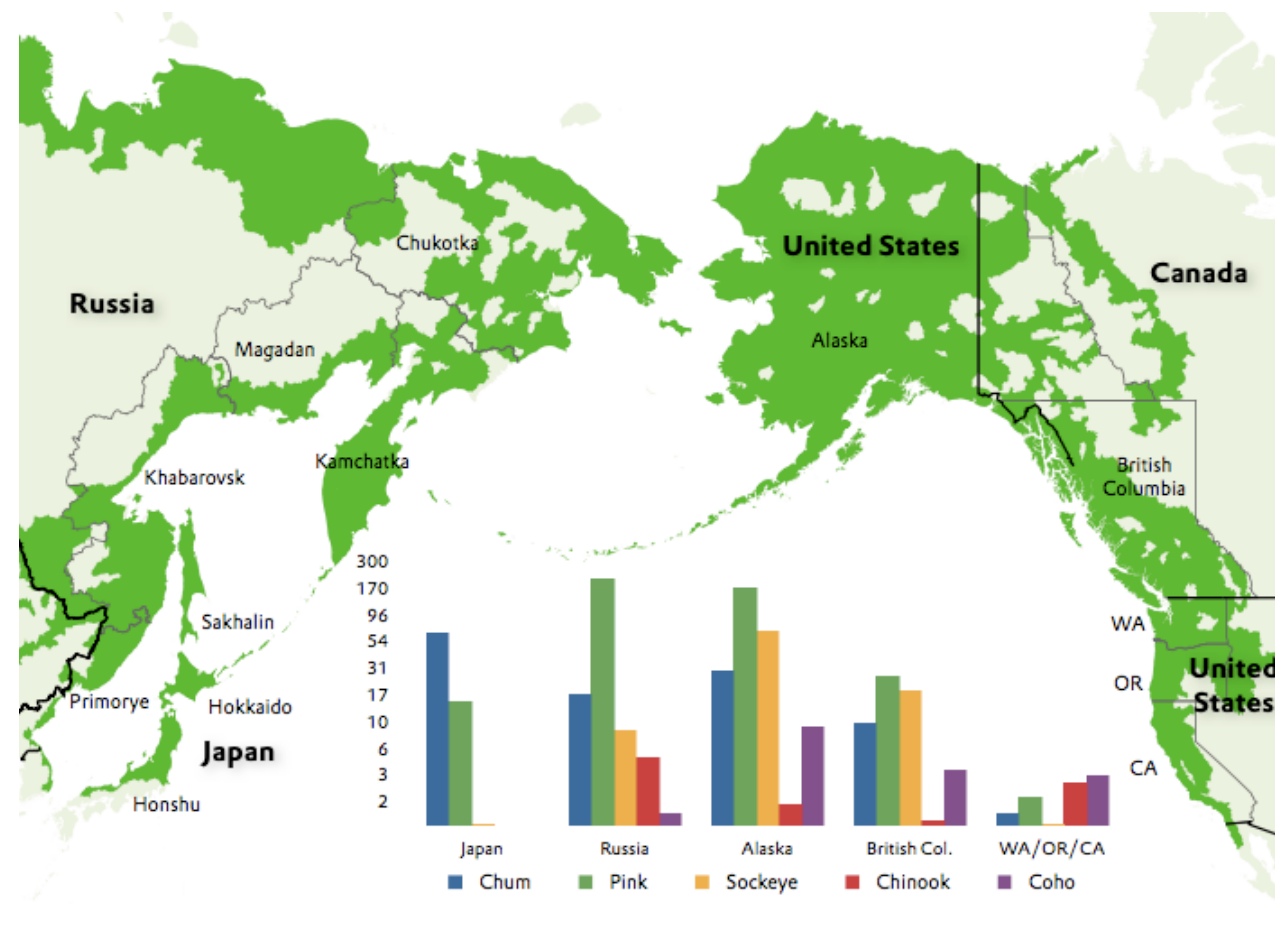
Fig. 1. The five salmon fisheries regions and log-transformed average total salmon run per year (catch and estimated total escapement, 1990–2000). Green shading indicates the geographic extent of Pacific salmon (Augerot and Foley 2005). Salmon run values include hatchery and wild salmon, but exclude catch by Japan in the Russian Exclusive Economic Zone. Masu is omitted because catch has just begun to be recorded regularly by Japan and Russia. Chinook and coho values are very preliminary. Data assembled by G. Ruggerone, Natural Resources Consultants, cartography D.